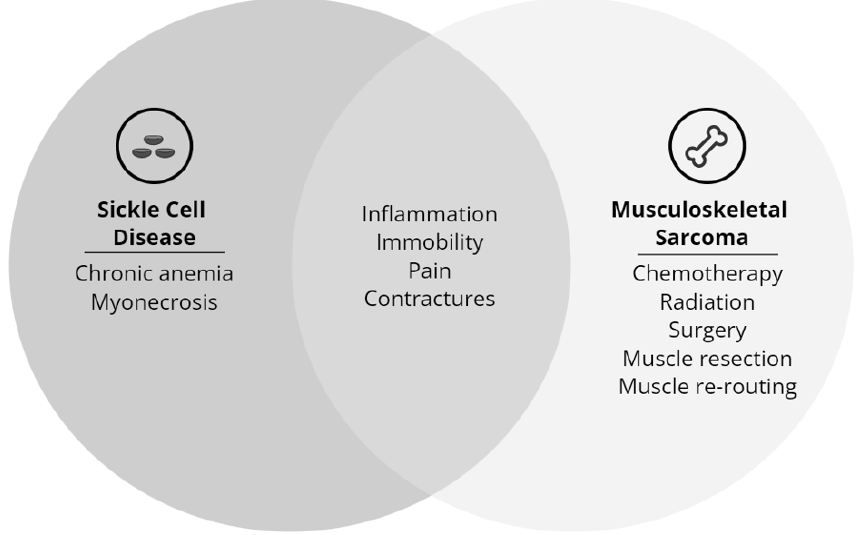
Figure 4. Underlying causes of skeletal muscle impairment in children with sickle cell disease (left), musculoskeletal sarcoma (right), and common causes across both diseases (center).